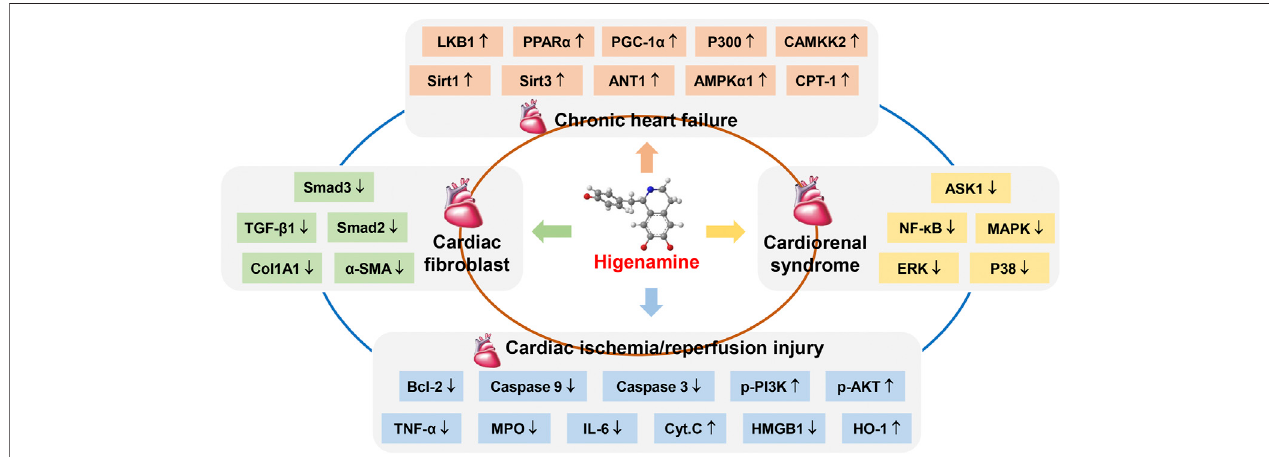
FIGURE2| Thepharmacologicaleffectofhigenamineonheartdiseasethroughmultipletargets. ↑ ,Higenaminehasanagonisticeffectonthistarget. ↓ ,Higenamine has an inhibitory effect on this target.